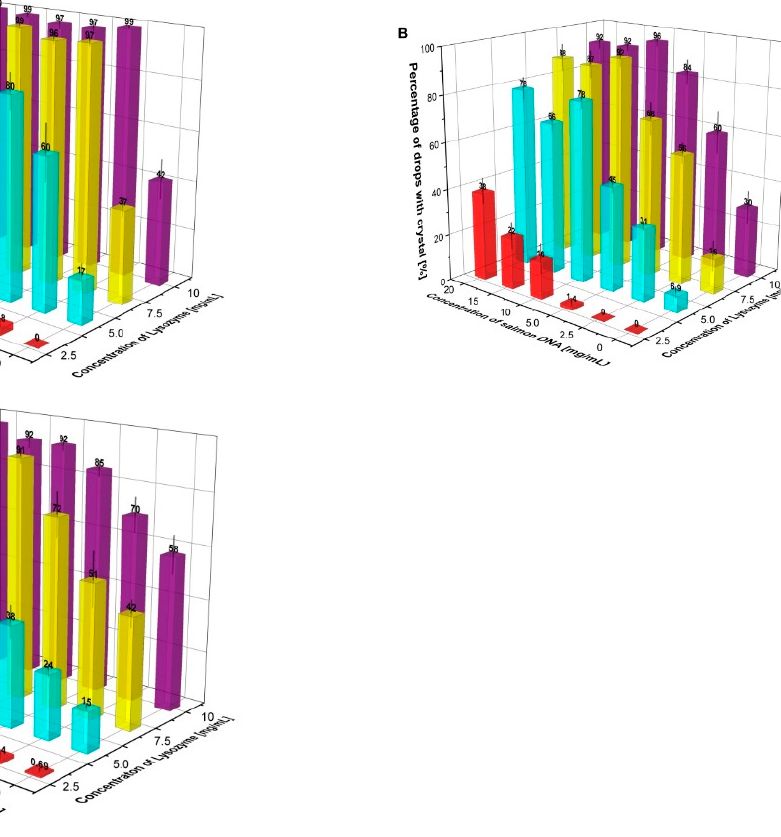
Figure 1. Crystallization success rate of lysozyme using ( A ) calf DNA ( B ) salmon DNA ( C ) herring DNA at 4 °C on the seventh day, respectively.